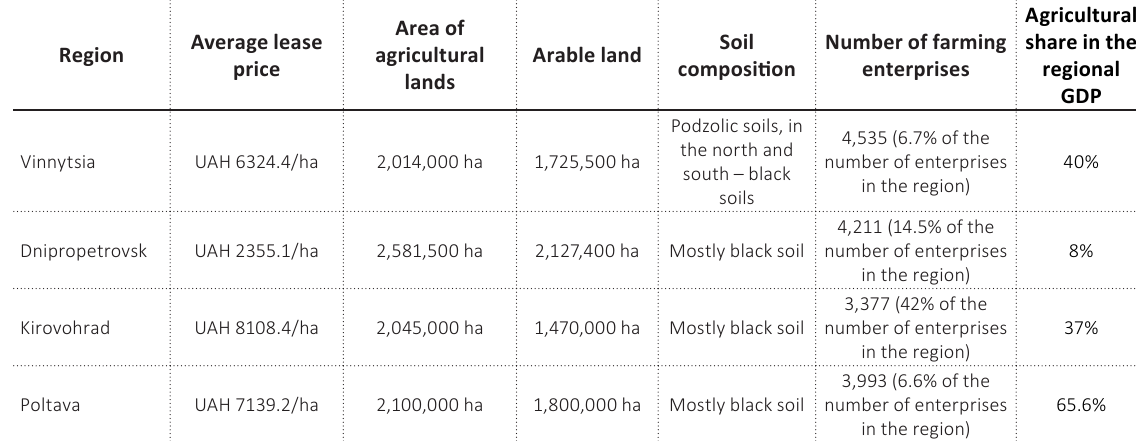
Table 1. State land value in some regions of Ukraine in 2020